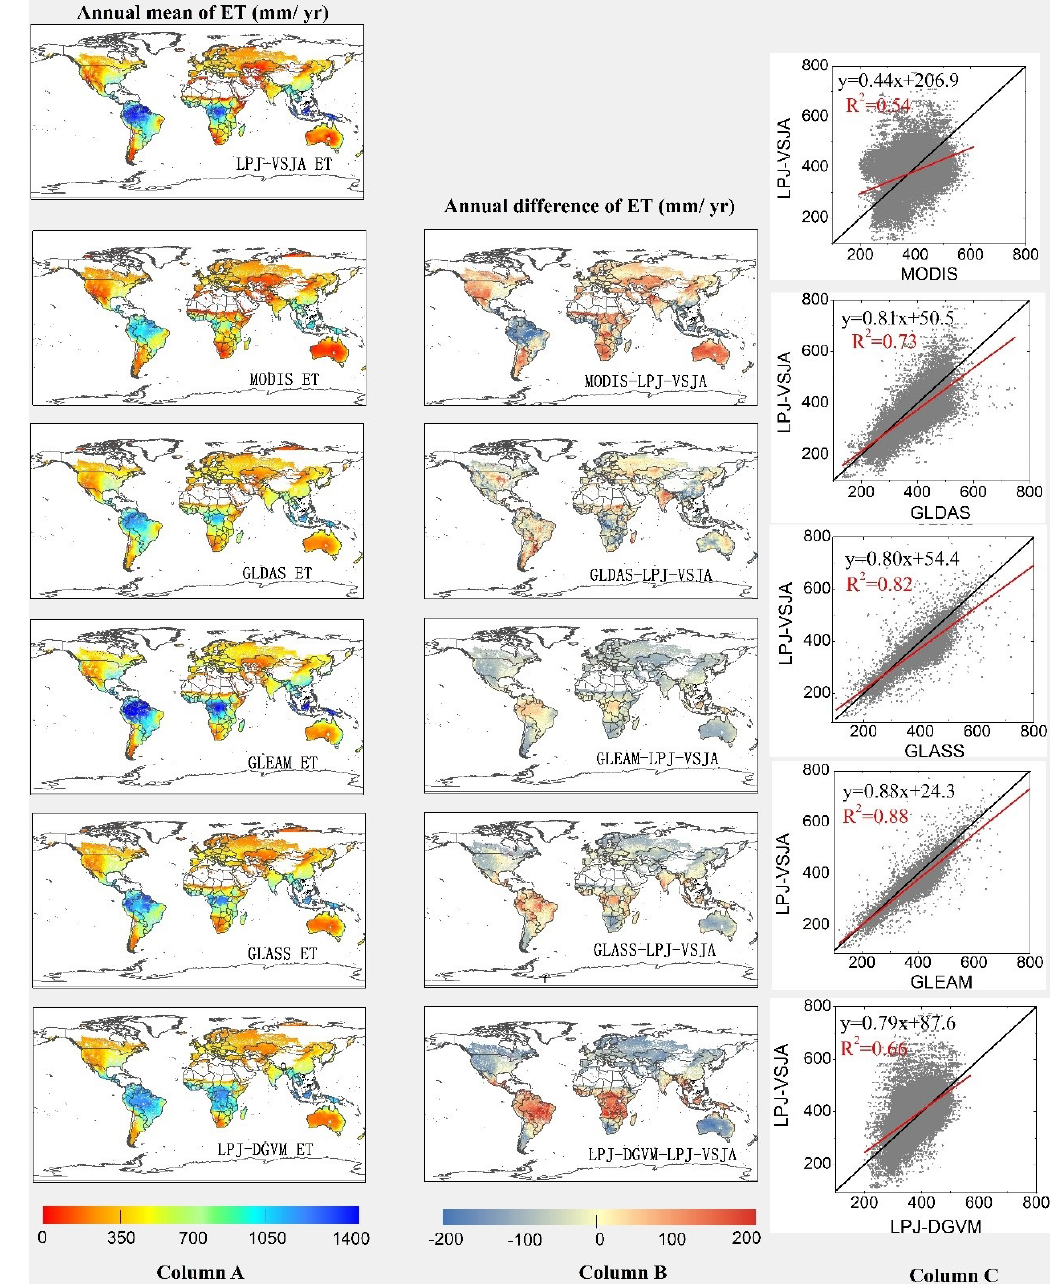
Figure 12. Column A: spatial distribution of annual LPJ-VSJA ET and other independent satellite-based datasets. Column B: spatial distri- bution of the difference between annual LPJ-VSJA ET and other independent satellite-based datasets. Column C: scatter plots between these products are provided on the right of the difference maps. Black lines show the 1:1 line, and red lines show the regression